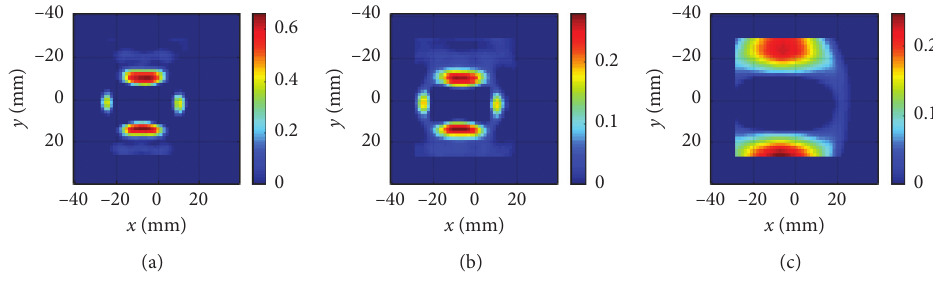
Figure 8: The imaging results of the single scatterer (TE wave).